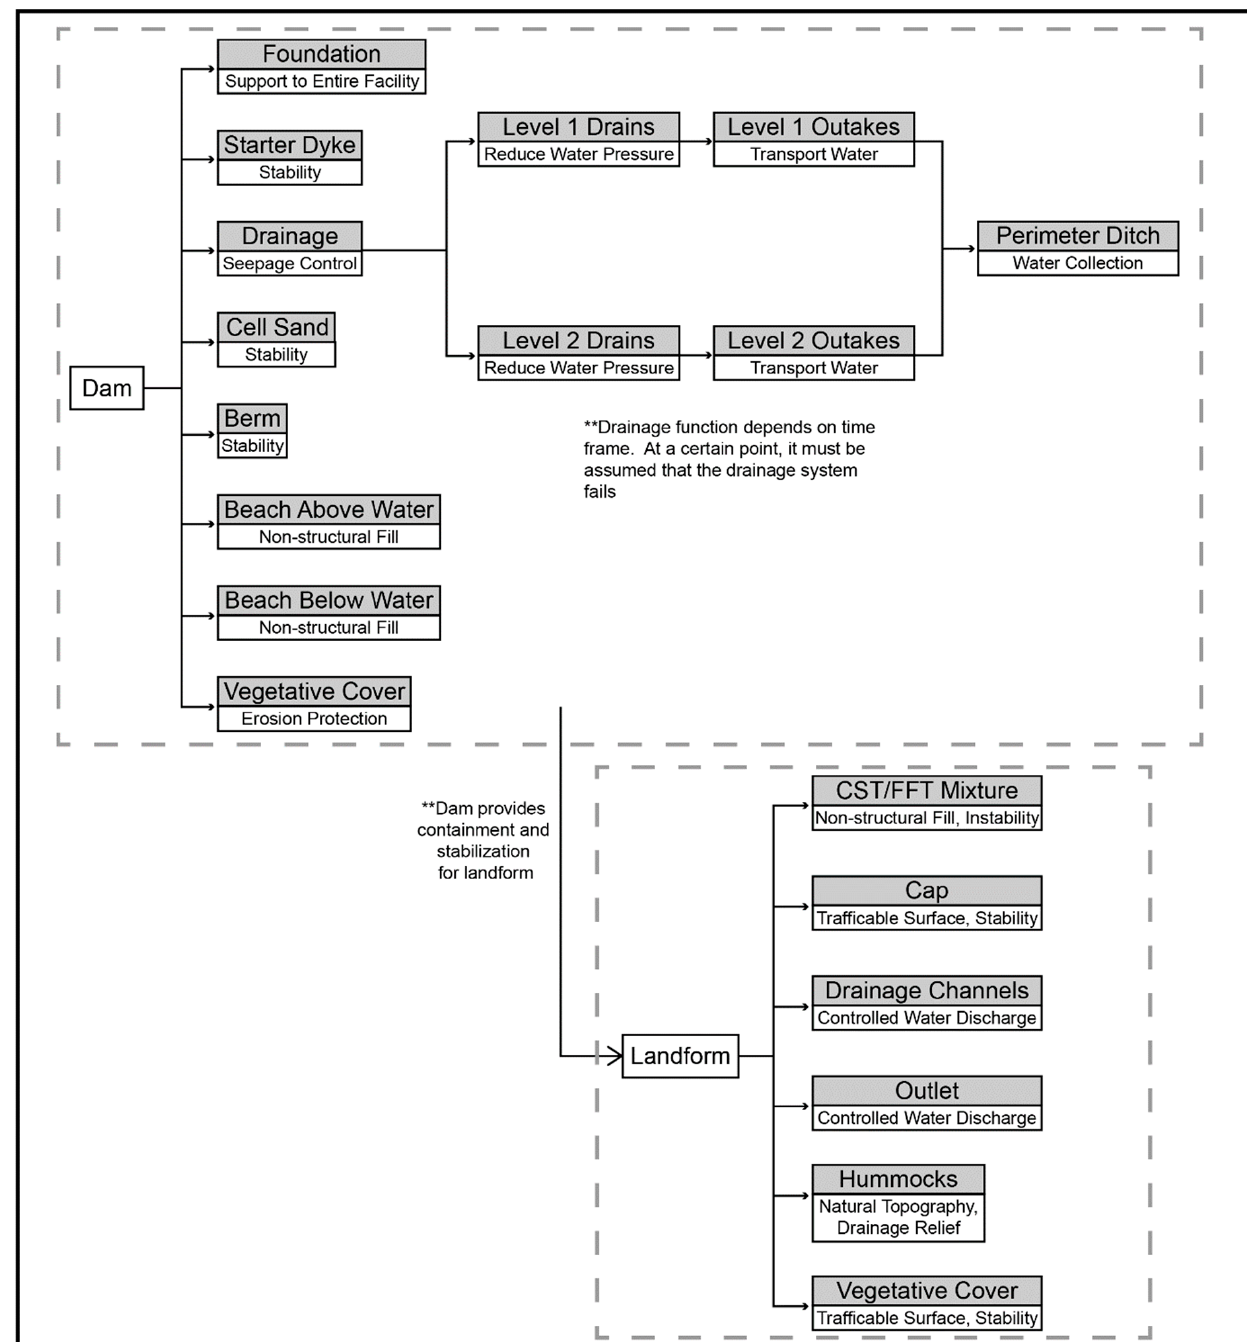
Figure 3. Case study block diagram.